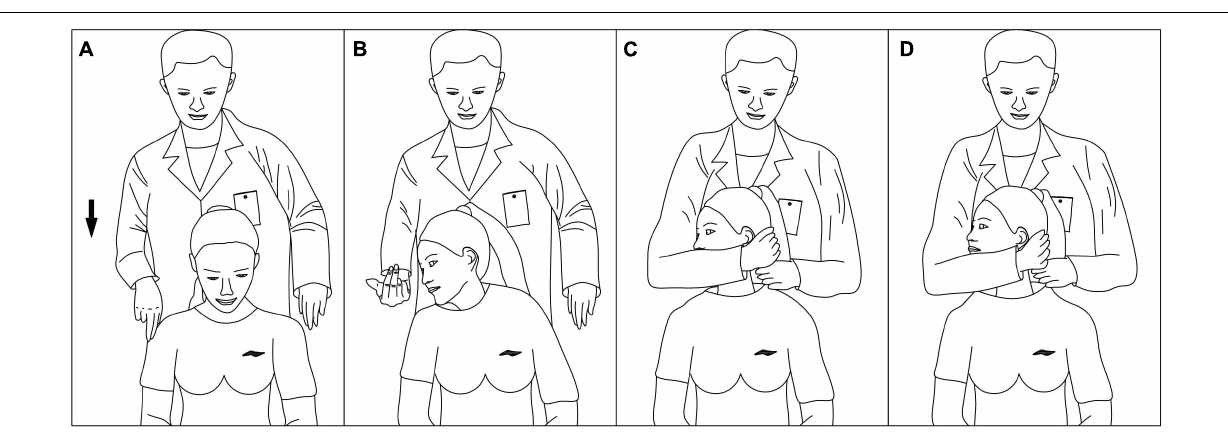
FIGURE 4 | Process of the cervical rotation–traction manipulation. (A) Flex. (B) Rotary position. (C) Pretraction. (D) Upward-thrust.